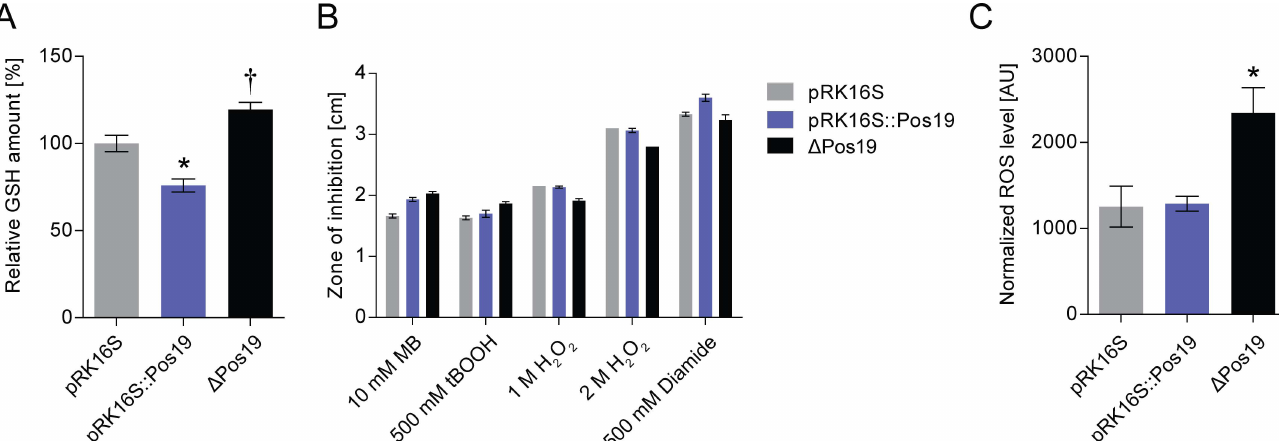
Fig 4. Pos19 influences GSH and ROS levels. (A) Measurement of total intracellular glutathione(GSH). GSH was measured using Ellmann’s reagent (DTNB) in cell samples from three R . sphaeroides strains: an empty vector control (pRK16S), a strain with a constitutive, plasmid-borne over- expression of Pos19 under the control of the 16S rRNA promoter (pRK16S::Pos19), and the Pos19 mutant ( Δ Pos19). The relative GSH amount is depicted in percent; the GSH amount of the empty vector control (pRK16S) was set to 100 percent. All results represent the mean of nine independent biologicalexperiments with technical duplicates. Error bars reflect the standard error of mean. The level of significance compared to the control (pRK16S) is indicated(† 0.05 < p < 0.1 and * p < 0.05). (B) Inhibitionzone assay using 10 mM methyleneblue (MB) in the light, 500 mM tBOOH, 1 M and 2 M hydrogenperoxide (H 2 O 2 ), and 500 mM diamide . The diameter of the zones of inhibitionwas measuredfor the three R . sphaeroides strains describedabove for the GSH assay. The data represent the mean of three independent experiments with technical duplicates. The error bars represent the standard error of mean. (C) Effect of Pos19 on ROS levels. Determination of intracellularlevels of ROS in the control strain (pRK16S) compared to Pos19 over-expression (pRK16S::Pos19) and mutant ( Δ Pos19). ROS generated by the cells were analyzedafter reaction with 10 μ M 2,7-dihydrodichlorofluorescein diacetate. The fluorescence intensity was normalized to the optical densities of the samples. The resulting values are presented in arbitrary units (AU). The data represent the mean of three independent experiments. The error bars indicate the standard error of mean. The level of significancecomparedto the control (pRK16S) is indicated( * p < 0.05).